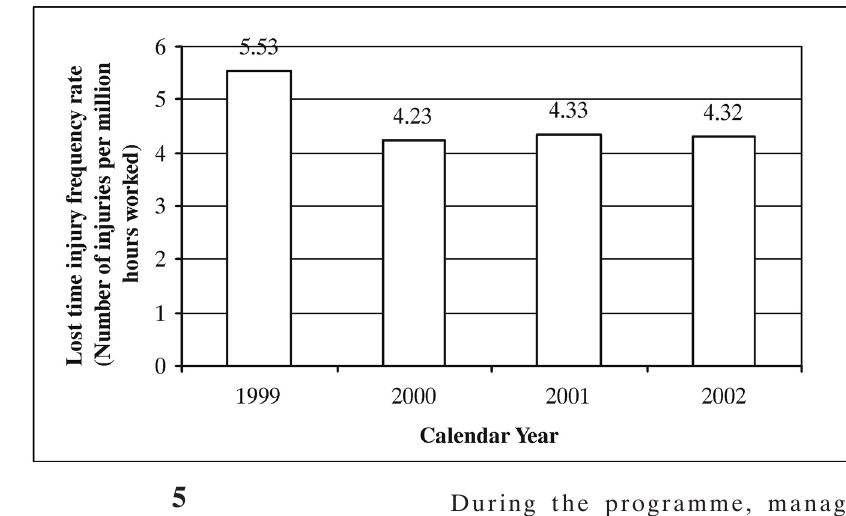
Trend for lost-time injury frequency